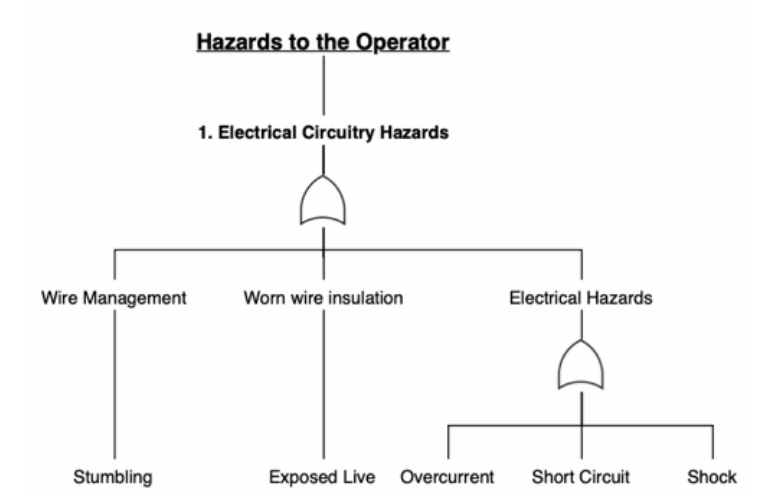
Figure 9. Function Means Analysis (Cyber Physical)